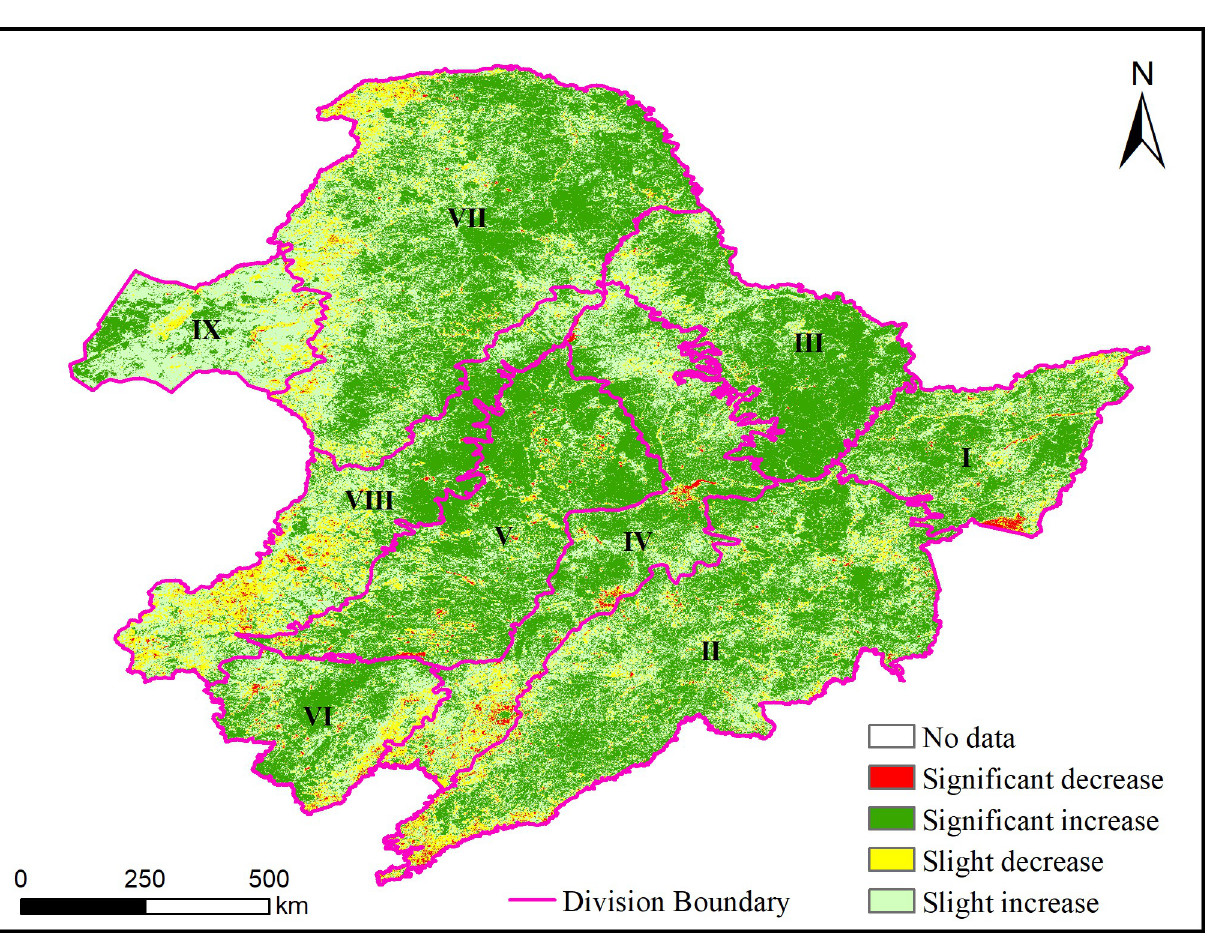
Fig 5. Results of NDVI trend analysis and significant test in Northeast China from 2001 to 2020. The NDVI data were obatined from NASA Earth Observatory (http://earthobservatory.nasa.gov/), and were further processed using Python program, MATLAB R2018b, ENVI 5.3 and ArcGIS 10.4 software.